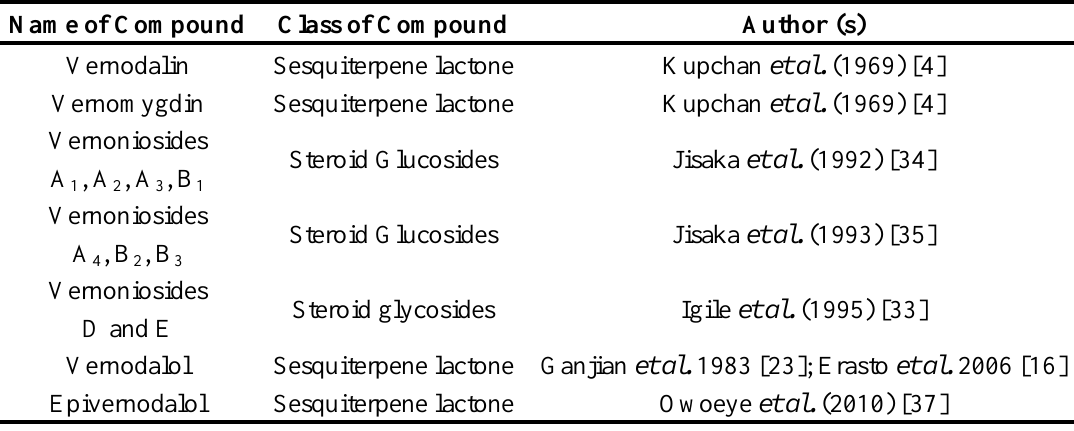
Figure 2. Some structures of compounds isolated from Vernonia